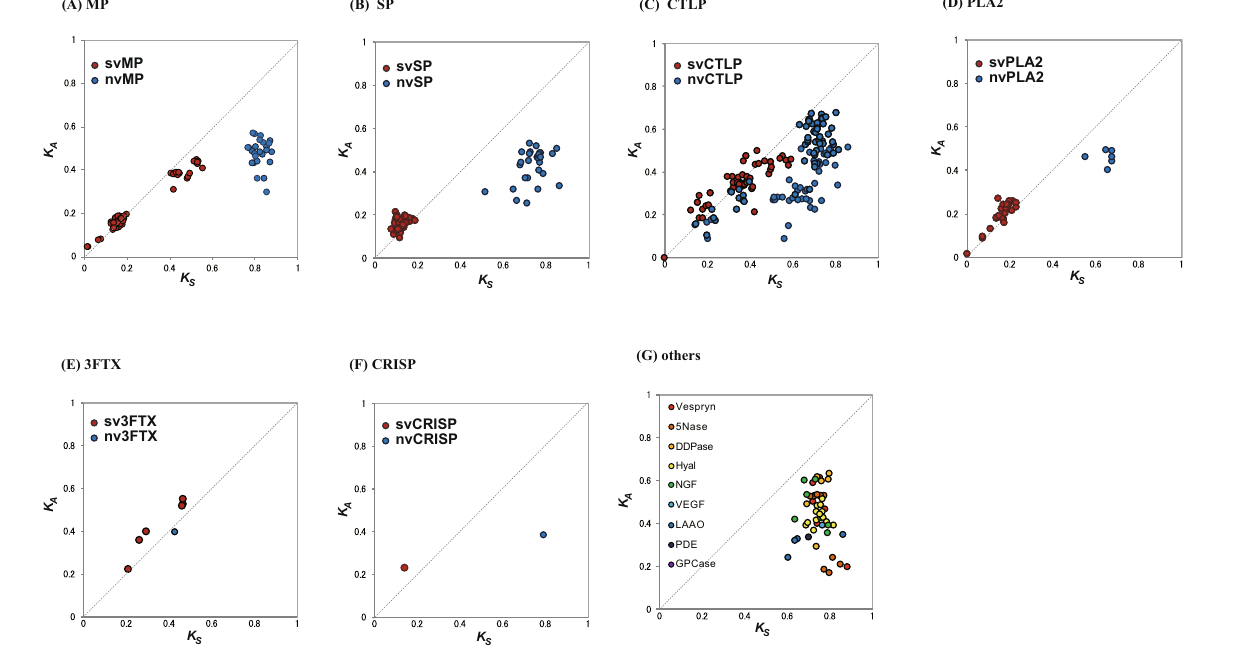
Figure 3. Accelerated evolution of major SV protein genes. K A and K S were calculated according to the Nei- Gojobori method. K A / K S plot for MP ( A ), SP ( B ), CTLP ( c ), PLA2 ( D ), 3FTX ( E ) and CRISP ( F ), and genes in Category I ( G ). In a to f, NV and SV genes are indicated by blue and red circles,